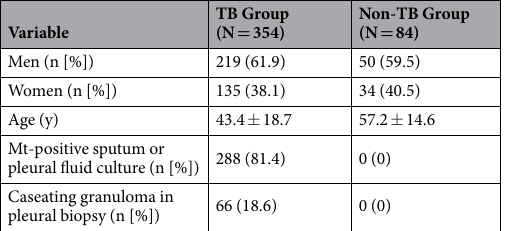
Table 1. Patient characteristics and study group assignment. TB, tuberculosis; Mt, Mycobacterium tuberculosis .